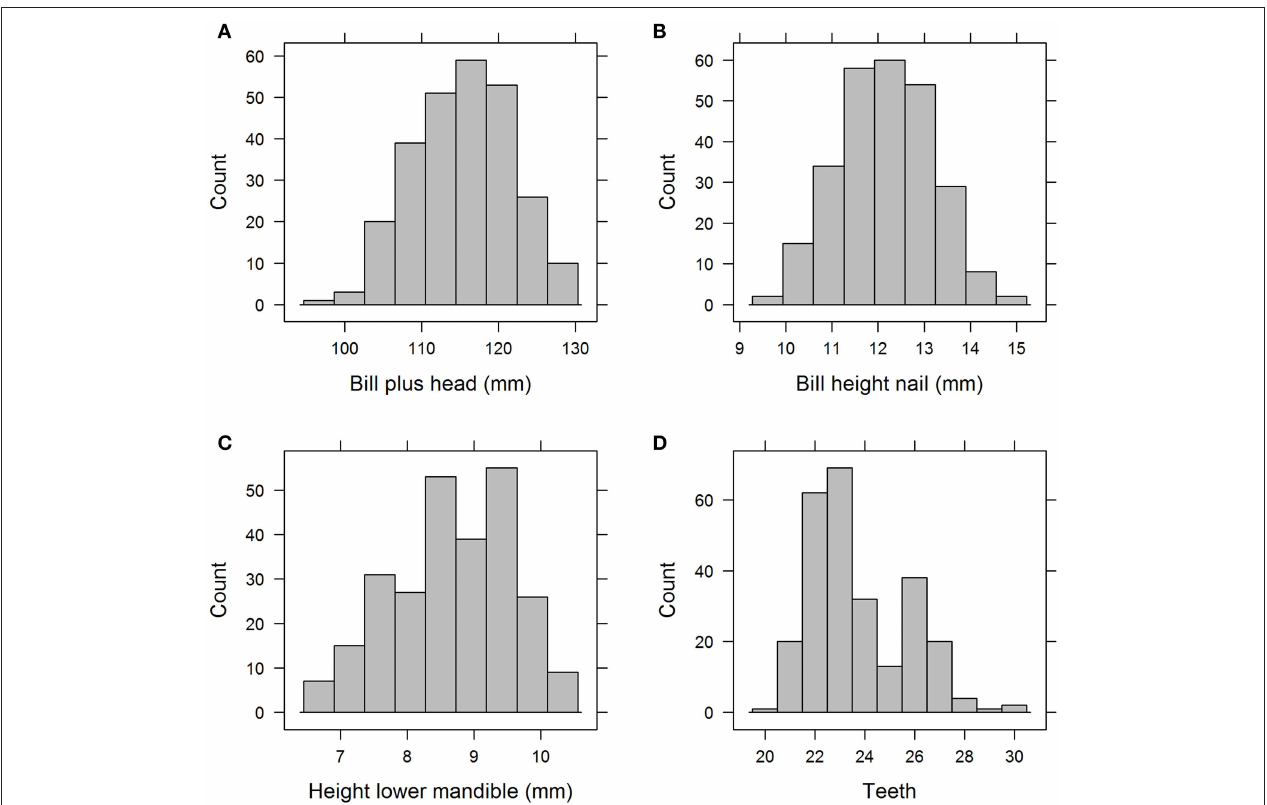
FIGURE 1 | Histograms of a selection of the 17 variables, “Bill plus head” (A) and “Bill height nail” (B) with unimodal distribution vs “Height lower mandible” (C) and “Teeth” (D) with bimodal distribution.